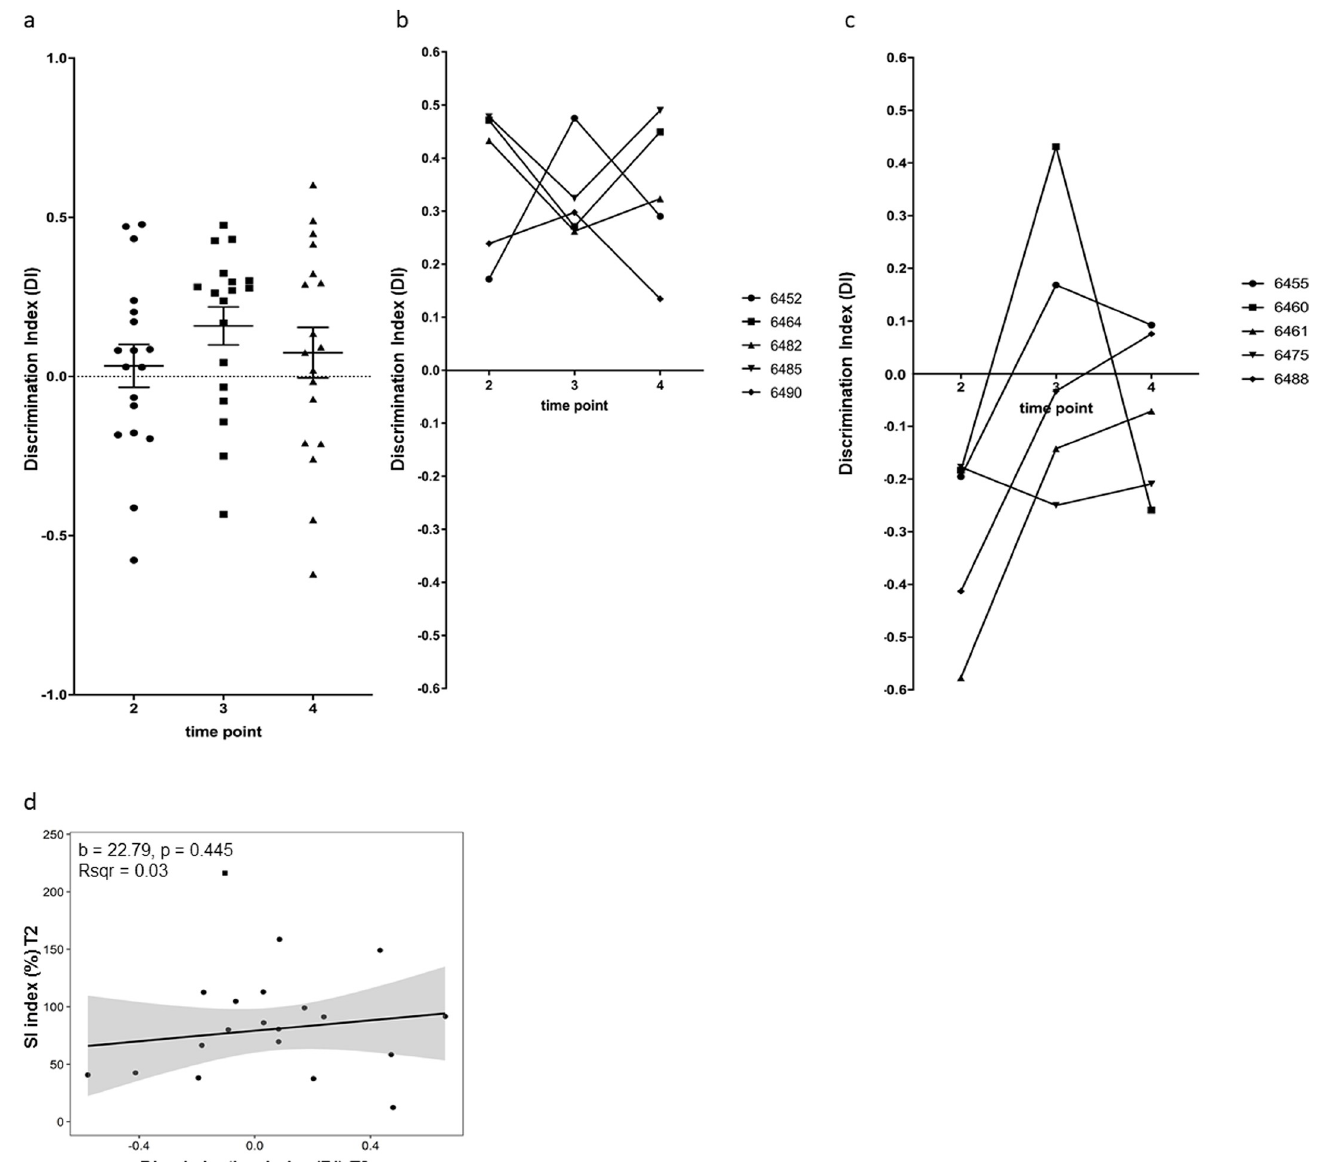
Fig 3. Longitudinal development of novel object recognition behavior after CSD stress. (a) Group dynamics of novel object recognition behavior in stressed mice at three different time points (T2-T4). DI scores were low at T2 and T4 and had temporarily improved at T3 after CSD exposure. (T2 vs. T3 p = 0.6162, T2 vs. T4 p > 0.9999, T3 vs. T4 p > 0.9999, ANOVA and Bonferroni’s post hoc test) (b) Longitudinal trajectories of stressed animals at T2-T4 of the 5 best performers chosen at T2. (c) Longitudinal trajectories of stressed animals at T2-T4 of the 5 worst performers chosen at T2. (d). Linear regression analysis using DI scores of stressed animals at T2 as independent and SI scores as dependent variable revealed no significant results for the regression coefficient b and the amount of variance explained as indicated by R-squared. The gray area around the regression line corresponds to the 95% confidence band. One animal was excluded from the regression analysis due to being a statistical outlier based on its SI score (shown as a square on the scatter plot). Non-linear trends in the relationship were investigated using a general additive model. Goodness of fit was not improved as confirmed by a likelihood ratio test, therefore a linear model was fitted to the data. Data are shown as mean ± standard error of the mean and individual